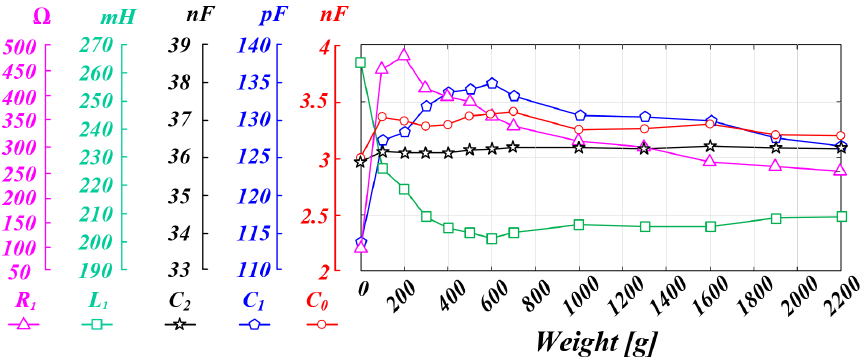
Figure 6. PT parameter change characteristic graph according to pressure fluctuation 2.